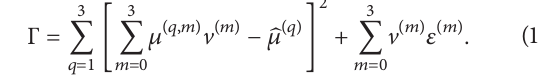
angle of 180 ∘ . The dark-current and flat-field images were also acquired at the beginning and at the end of each